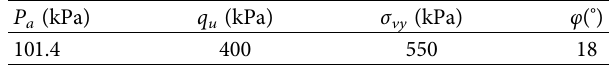
Table 3: Values of other parameters for “ m ”